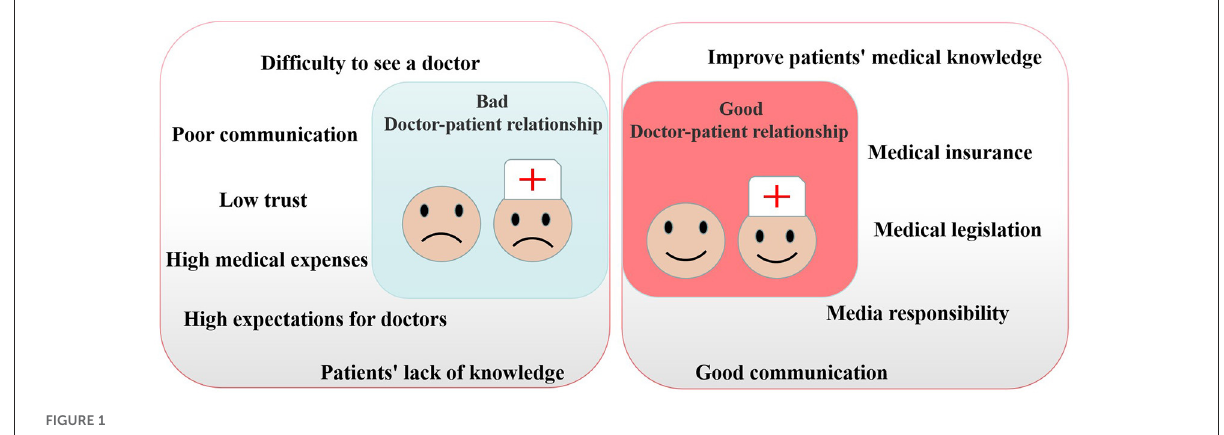
FIGURE1 Factors affecting doctor-patient